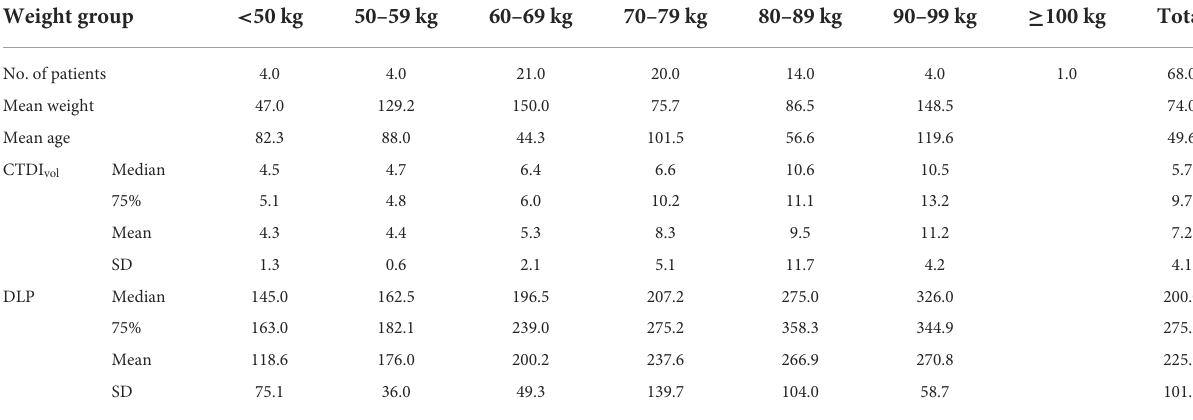
TABLE 4 Distribution of chest CT without CM for patients in different weight groups.